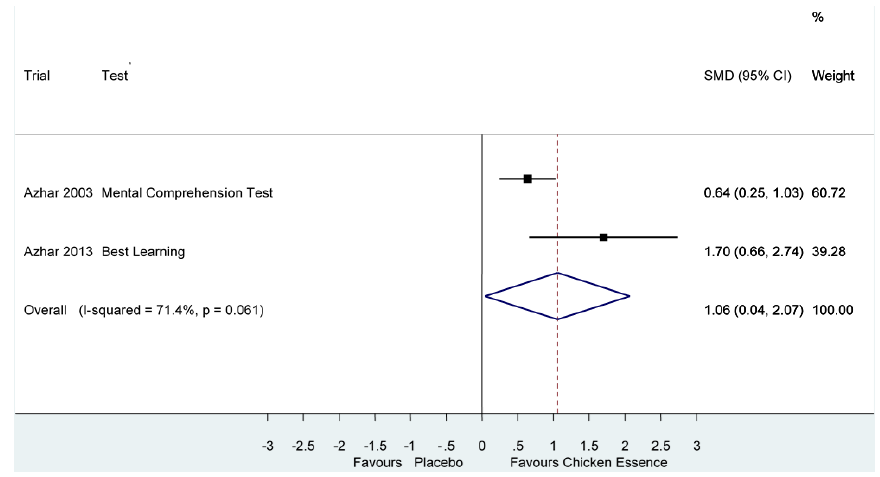
Figure D2. Pooled effect estimate of score of short-term memory tests (with Azhar’s test removed [15]).